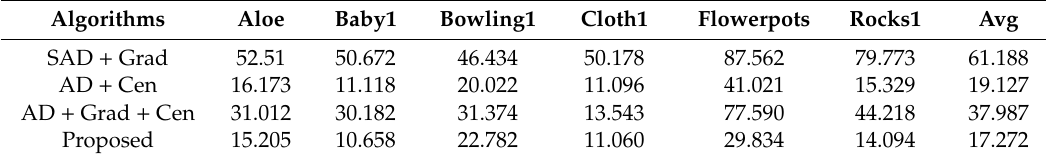
Table 4. Error matching rate of various cost computation without radiometric